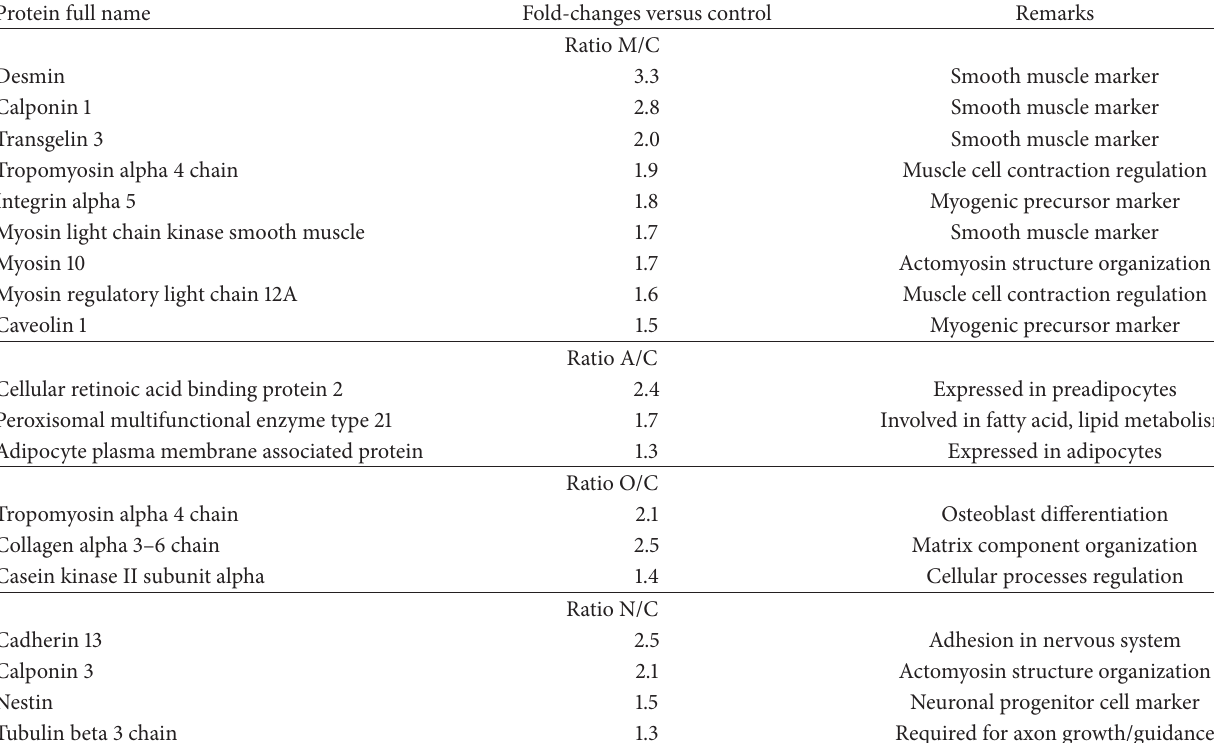
Table 2: Lineage-specific proteins upregulated in AF-MSCs undergoing myogenic (M), adipogenic (A), osteogenic (O), and neurogenic (N) differentiation. A mean ratio above 1.3 is defined as upregulated expression in differentiated